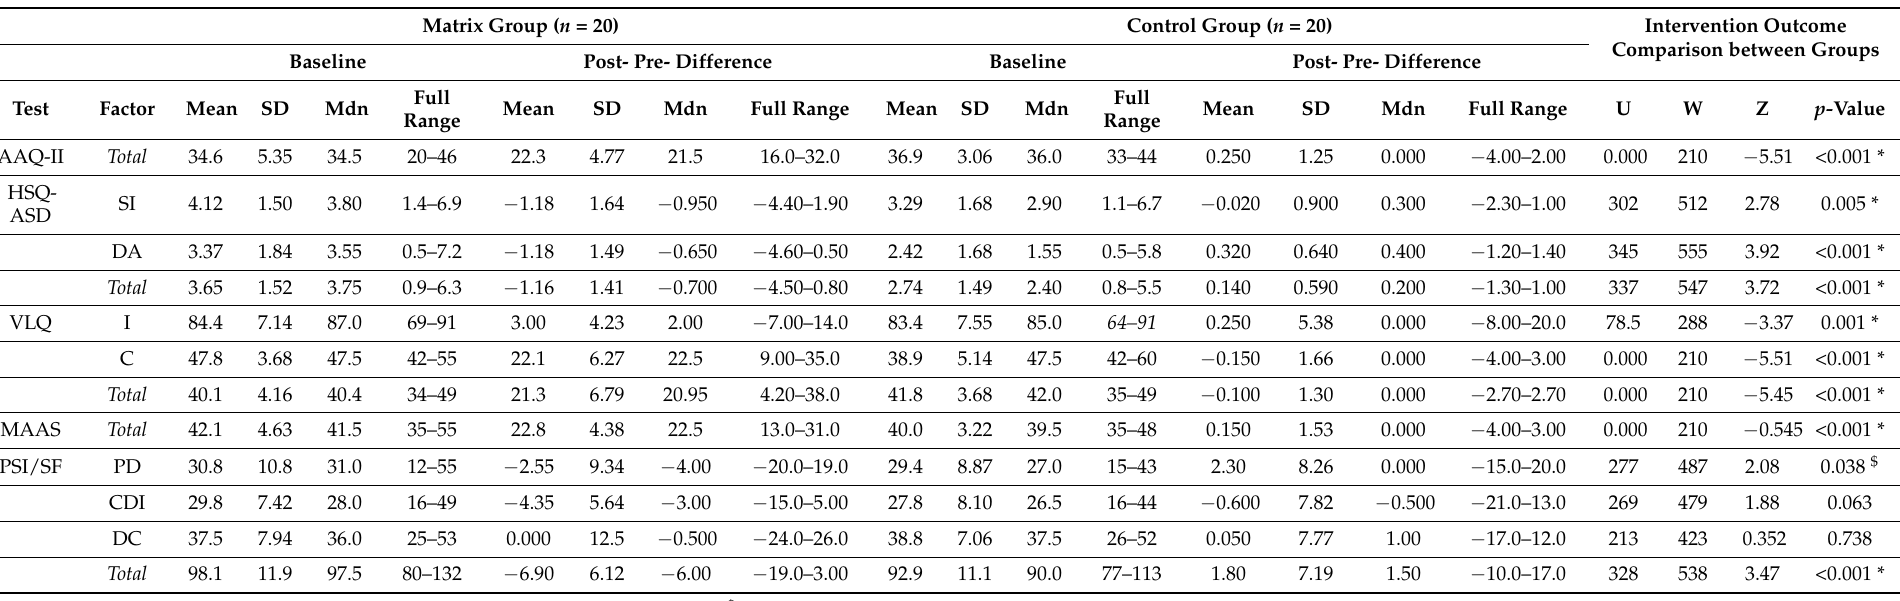
Table 2. Delta of improvements in outcome measures between matrix and Parent Training